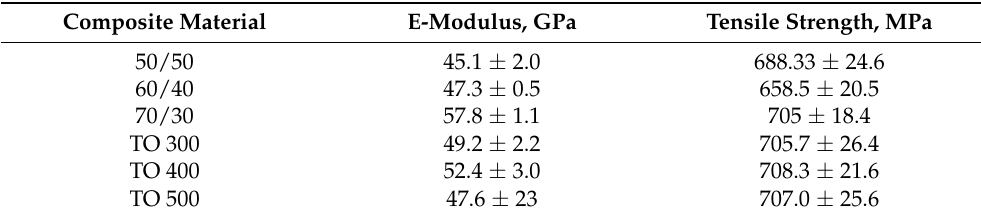
Table 3. Results of tensile strength test (composites reinforced with modified fibers containing 50 wt. % of CF).